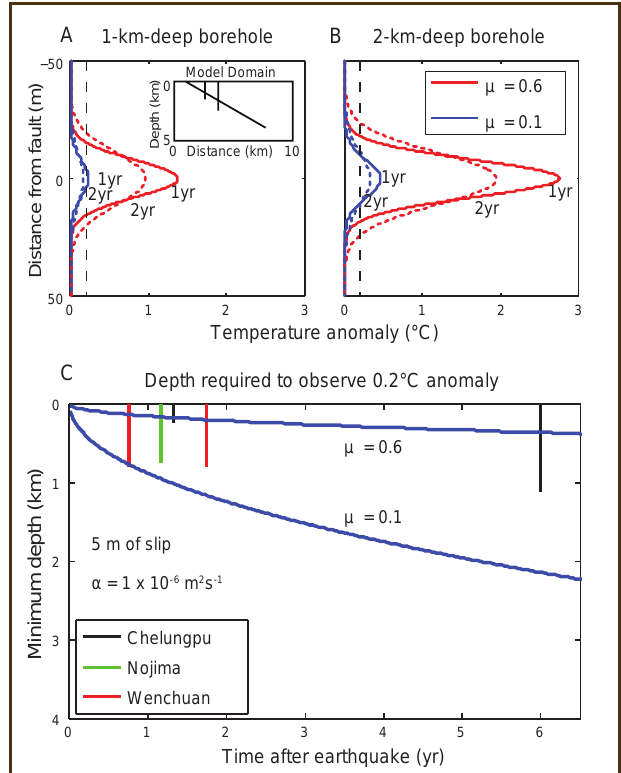
Figure 1. Frictional temperature anomalies resulting from a thrust earthquake with 5 m of slip and assuming a thermal diffusivity α of 10-6 m2s -1 . (from Fulton et al., 2008) [A] Temperature anomaly for a borehole intersecting the fault at 1-km depth. Red and blue lines show frictional heating for effective friction coefficients of 0.6 and 0.1, representing strong and weak faults, respectively. Solid and dashed lines show the frictional heating anomaly one and two years after the earthquake, respectively. Dashed vertical black line shows the assumed detection threshold of 0.2°C. [B] Temperature anomaly for a borehole intersecting the fault at 2-km depth. [C] Blue lines show the minimum depth of borehole intersection with a fault to observe a temperature anomaly of 0.2°C as a function of time. The depth and timing of borehole completion of fault-zone drilling experiments are shown as vertical lines at the top of the panel [Figures from Fulton et al.,